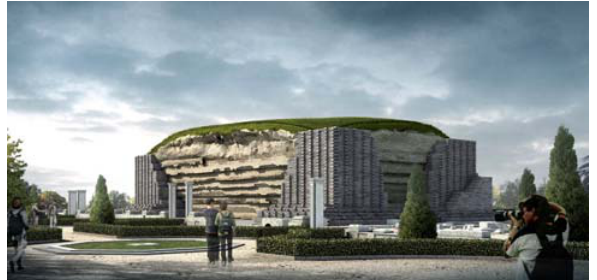
Figure11. Effect drawing for the